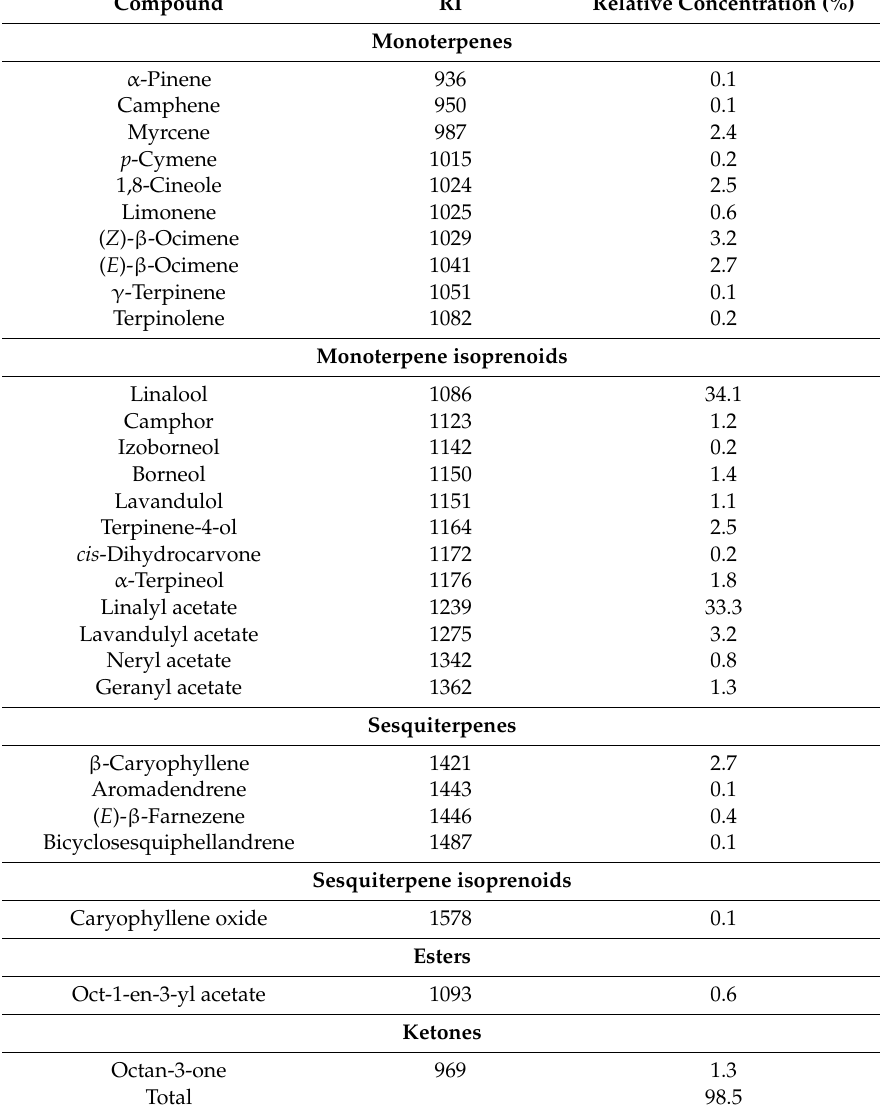
Table 1. Chemical composition of volatile constituents of commercial lavender essential oil from the flowering herb of Lavandula angustifolia Mill. ( Lamiaceae ).